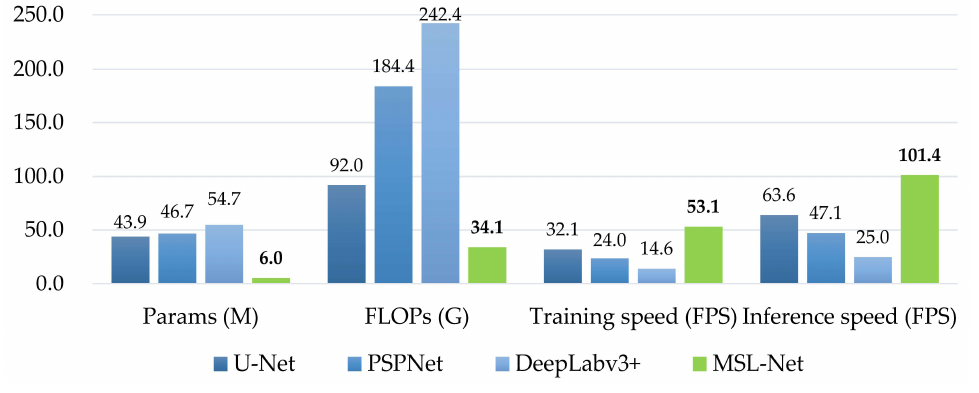
Figure 10. Complexity comparison.